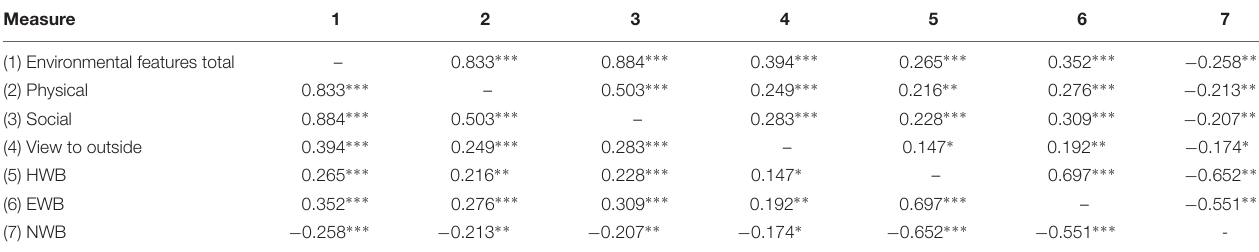
TABLE 3 | Pearson correlation coefficients for environmental features and wellbeing. Measure